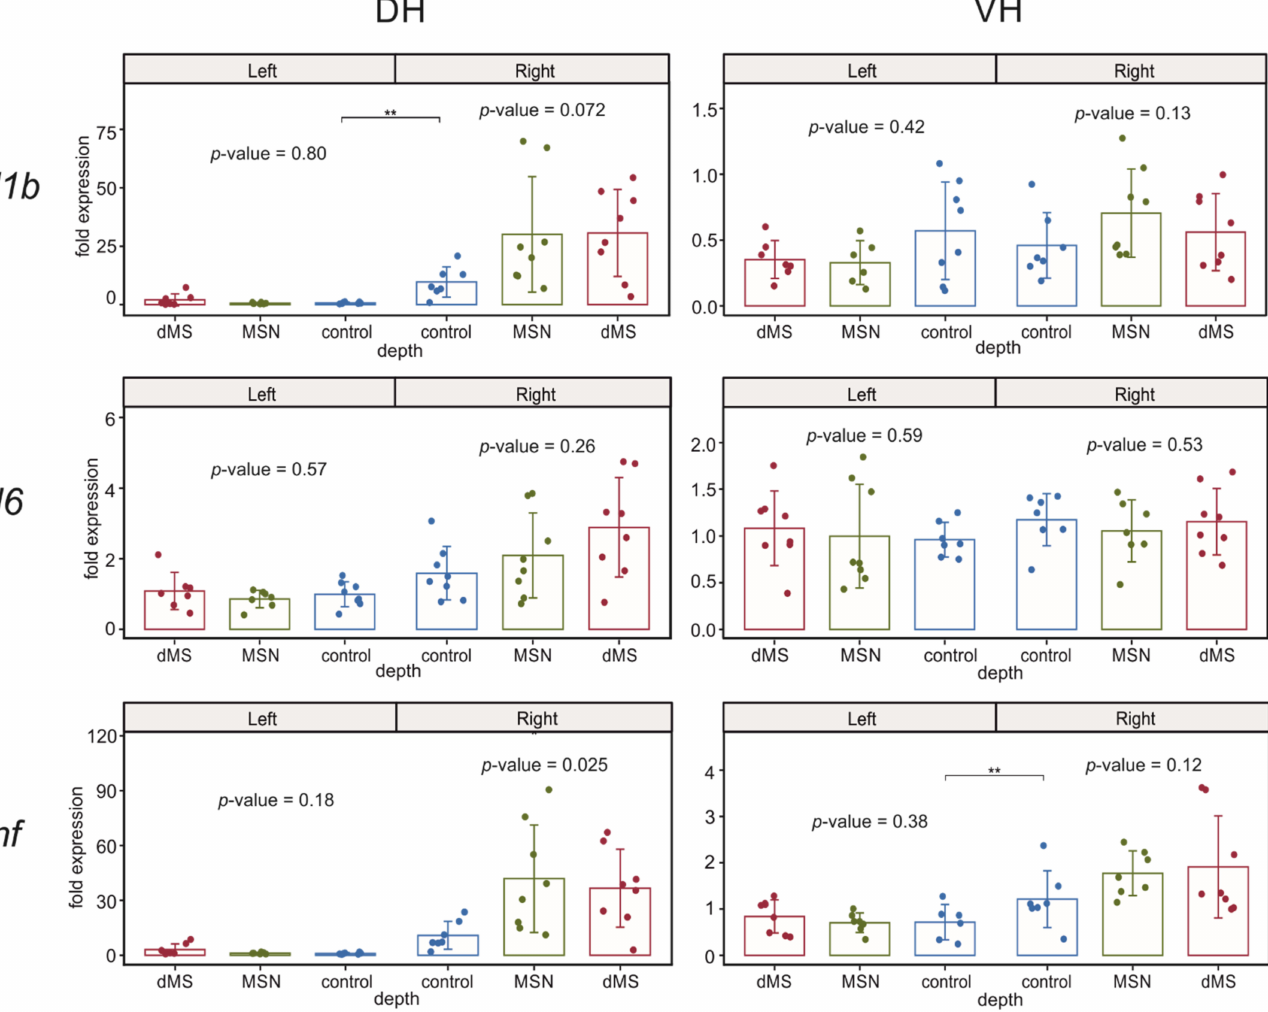
Figure 5. Changes in the expression of inflammatory cytokines after stimulation of the dorsal medium septum and medial septal nucleus in dorsal and ventral parts (DH and VH, respectively) of the left (intact) and right (damaged by implanted electrode) hippocampi. p -values are shown for Kruskal– Wallis test for comparison of three groups in one hemisphere. Interhemispheric comparisons were performed only in the control group using the Mann–Whitney test. For interhemispheric comparisons, ** mark significant differences at p < 0.01 (Mann–Whitney